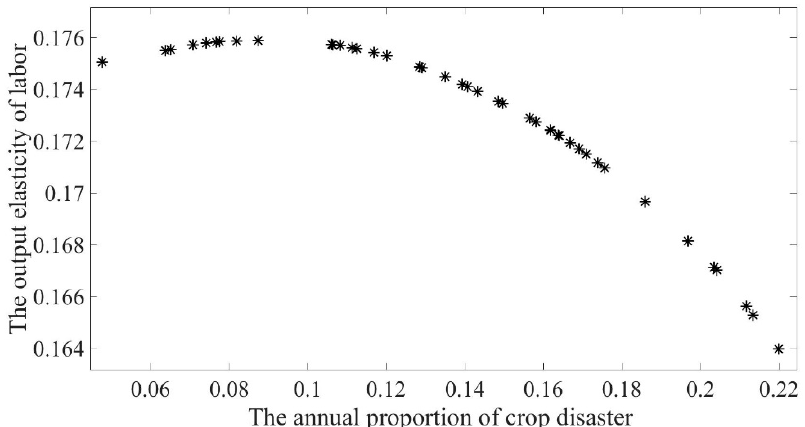
Figure 5. The relationship between the output elasticity of labor and the annual proportion of crop disasters.